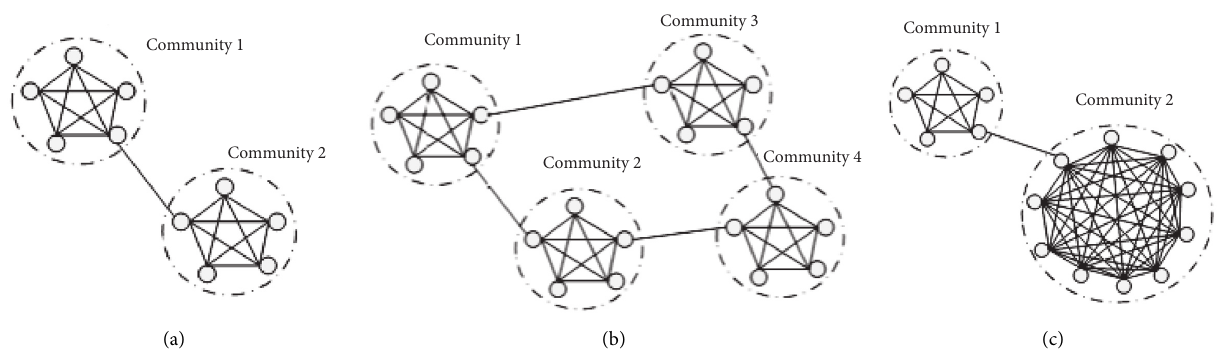
Figure 2: Schematic diagram of community structure. (a) Network1. (b) Network2. (c) Network3.